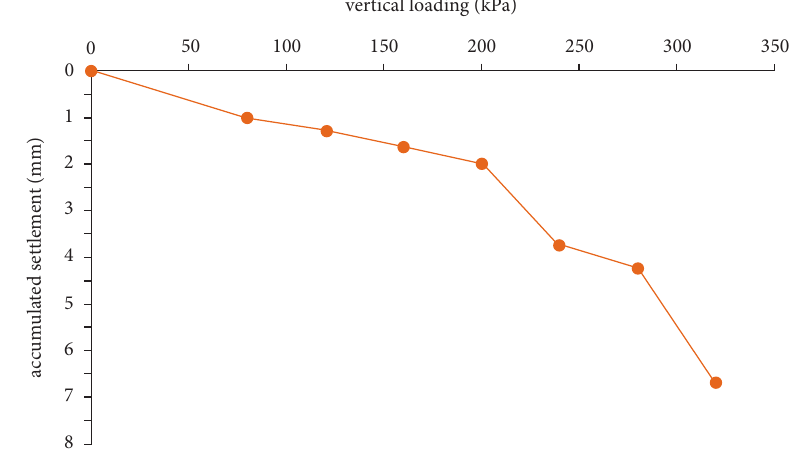
Figure 3: Pictures of test loading process. Table 1: Load settlement data